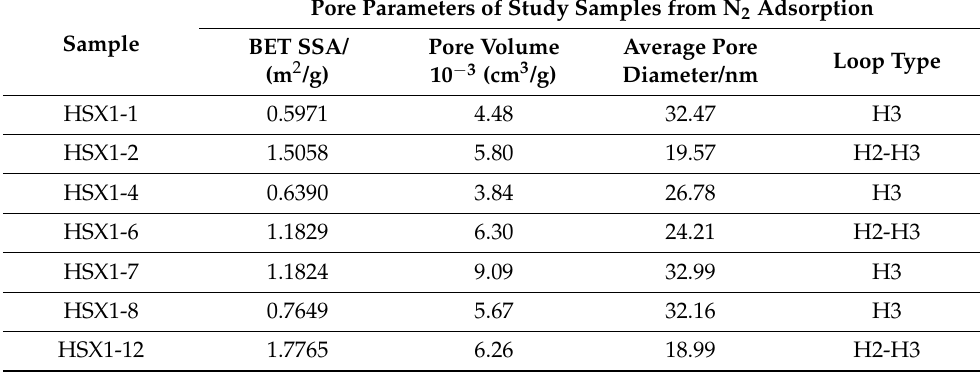
Table 2. Pore structure parameters of shale from Fengcheng